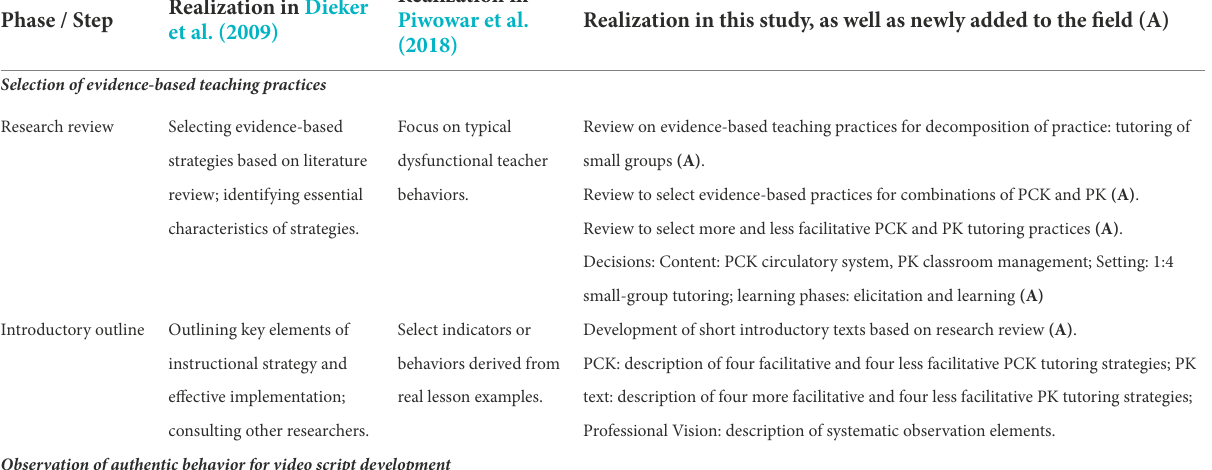
TABLE 1 Design process of scripted video case development in this study based on previous